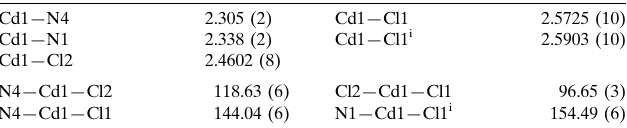
Selected geometric parameters (A˚ , (cid:2) ).